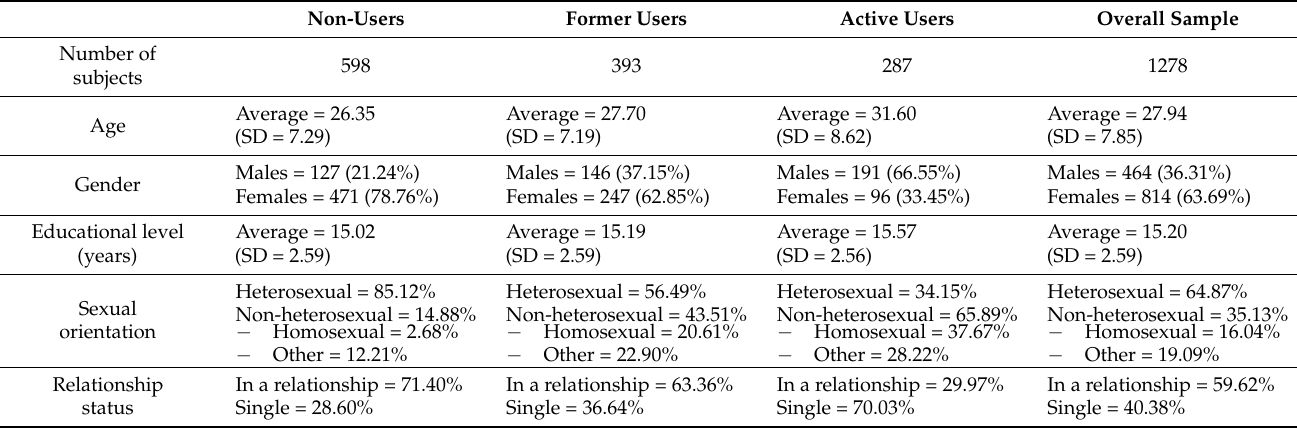
Table 1. Demographic characteristics among active users, former users, and non-users. Percentages were rounded up from